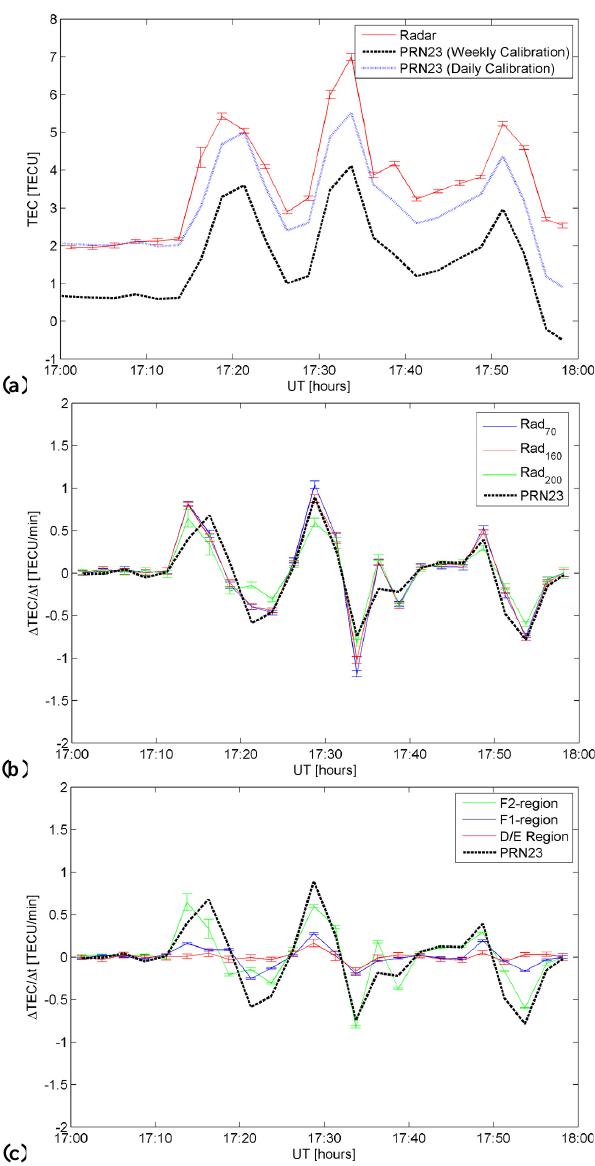
Fig. 4. Comparison of slat TEC and its temporal fluctuations be- tween radar and GPS for the measurements from Tromsø on 12 De- cember 2011. (a) Slant TEC as obtained from EISCAT (Tromsø, 12 December 2011) electron density profiles integrated between 70km altitude and 500km range in comparison with estimates of the GPS TEC along the same line of sight. (b) Temporal fluctua- tions in slant TEC along the EISCAT (Tromsø, 12 December 2011) line of sight as integrated from altitudes 70km (blue), 150km (red), 200km (green) upwards until range 500km. Temporal fluctuations in slant TEC from PRN23 (dashed black) along the same direction are shown as well. The temporal fluctuations are calculated over an interval of approximately 150s. (c) Contributions to temporal fluc- tuations in TEC from different ionospheric layers (i.e. D/E, F1 and F2 nominally) in comparison with the overall GPS TEC fluctua- tions (Tromsø, 12 December 2011). The temporal fluctuations are calculated over an interval of approximately